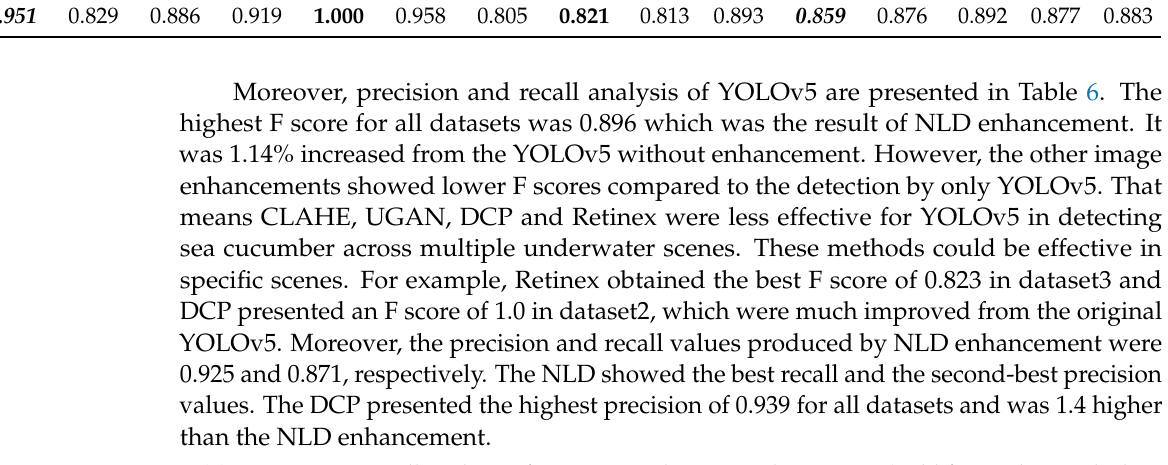
Table 6. Precision–recall analysis of YOLOv5 with image enhancement (Bold font indicates the best result and italic indicates the second-best